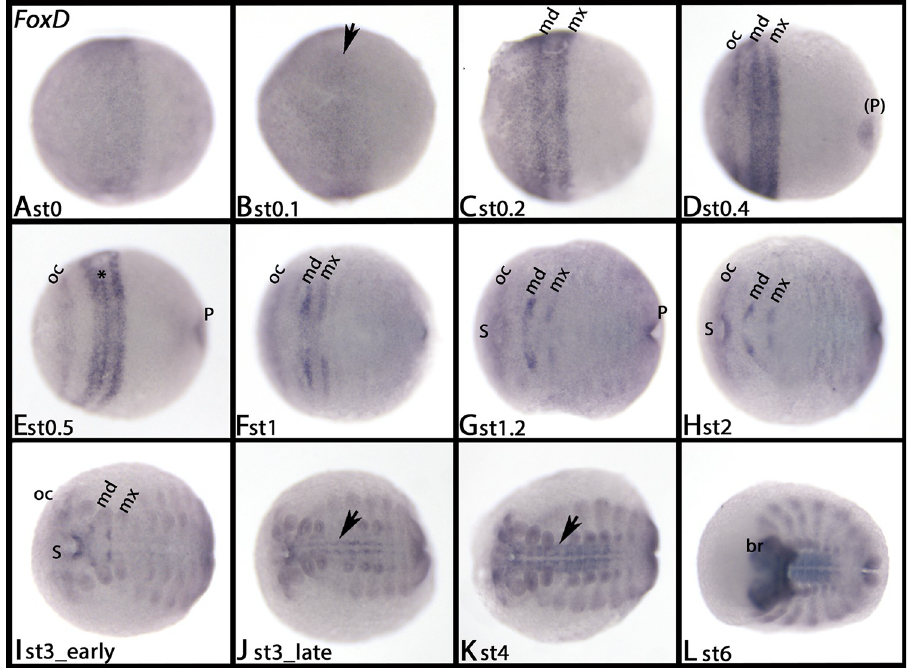
Fig 5. Expression of Glomeris FoxD . In all panels, anterior is to the left, ventral views. The arrow in panel B marks an appearing stripe of expression in the (likely) mandibular segment primordium. The asterisk in panel E marks the mandibular segment. Arrows in panels J and K mark expression in the VNS. Abbreviations in Table